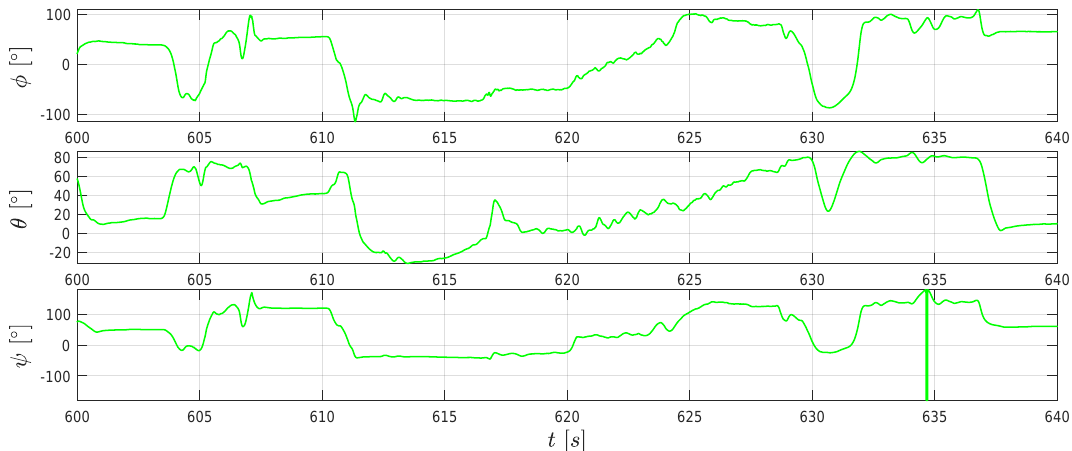
Figure 11. The extended RTS smoother estimated attitude angles: φ , θ , and ψ